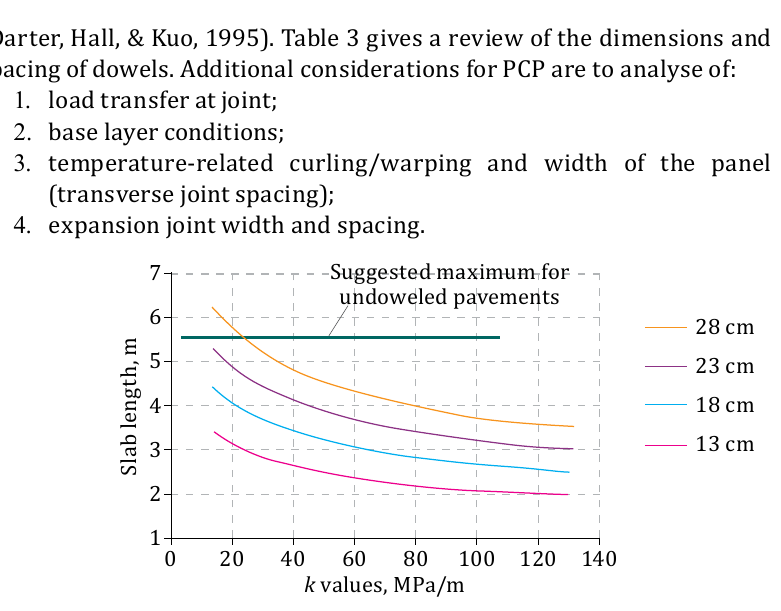
Figure 3. Recommended ratio between slab length and pavement thickness (American Concrete Institute…, 2002) Table 3. Review of dimensions and spacing of dowels Thickness of slab,